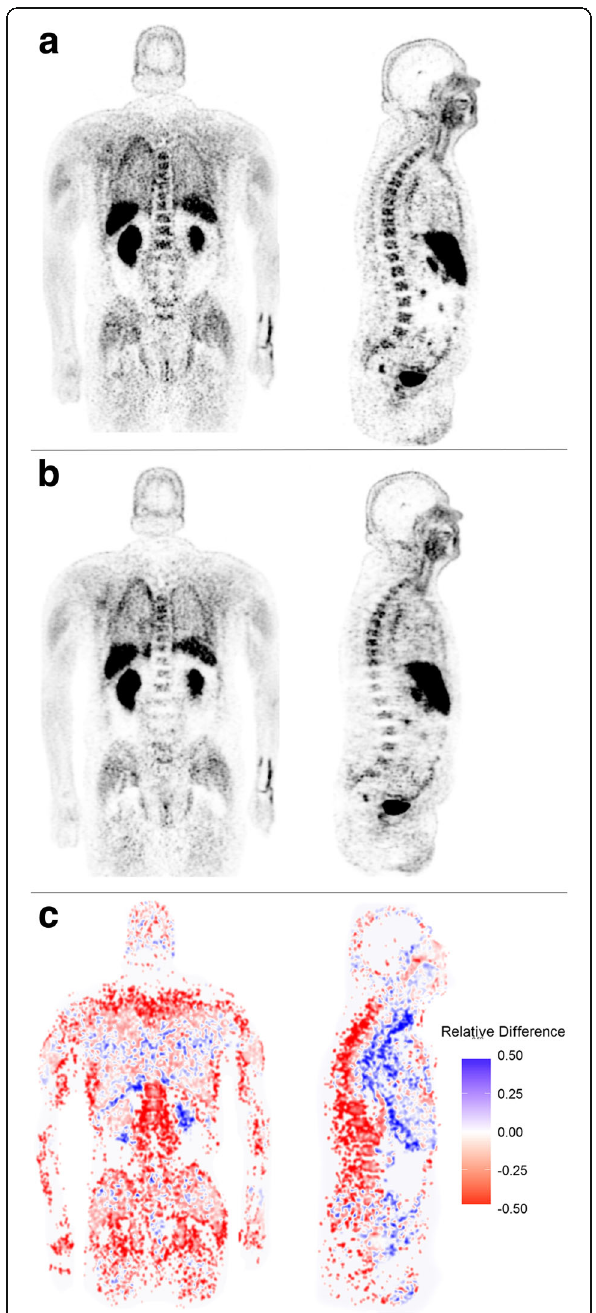
Fig. 2 Coronal and sagittal TOF 18 F-choline PET reconstruction ( a ). Coronal and sagittal non-TOF 18 F-choline PET reconstruction ( b ). Relative percentage difference image (TOF - non-TOF)/TOF ( c ). Note the differences in the vertebra, the pelvic region, and the